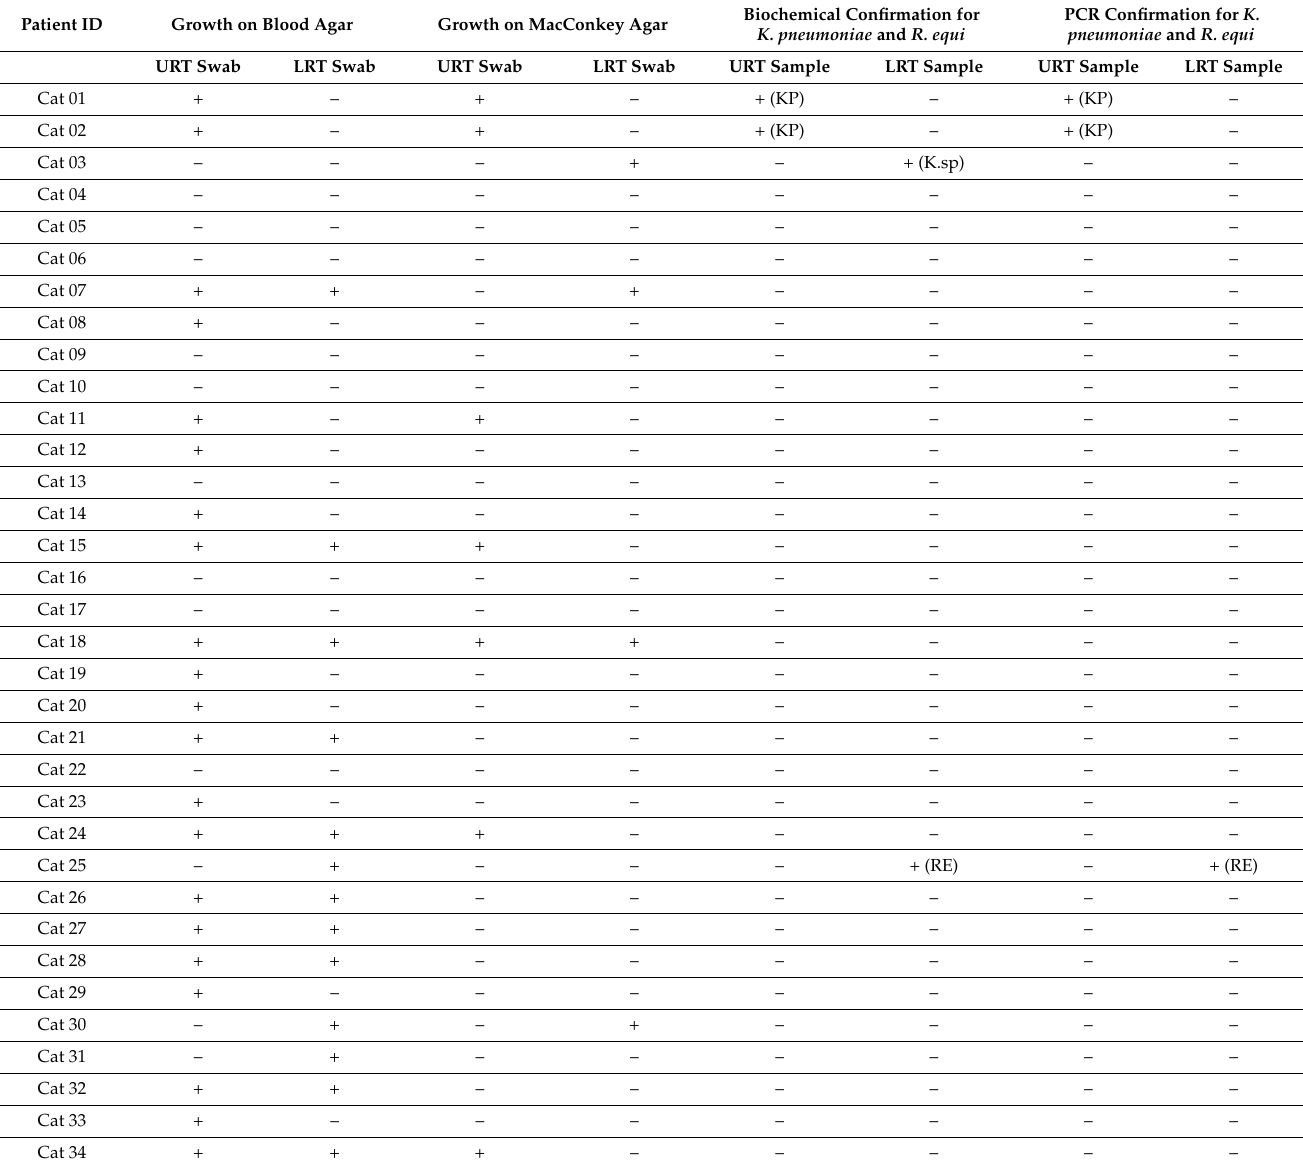
Table 7 indicates the complete sequel of individual sample collected from all 34 cats with final outcome. Tracheal and nasal swabs were collected from shelters’ cats while only nasal swabs from privately-owned cats for URT infection(s). Similarly, lung swabs were collected from shelters’ cats while pleural effusions from privately-owned cats. A total of 62% ( n = 21) samples from URT and 38% ( n = 13) samples from LRT produced some kind of bacterial growth(s) on blood agar. Same swabs were used on MacConkey agar and produced some growth(s) from 24% ( n = 8) samples collected from URT and 9% ( n = 3) samples from LRT. Table 7. Summary of the bacterial culture, biochemical and molecular confirmation results from URT and LRT samples in a total of 34 (22 shelter and 12 privately owned) cats manifested acute/chronic infectious respiratory disease